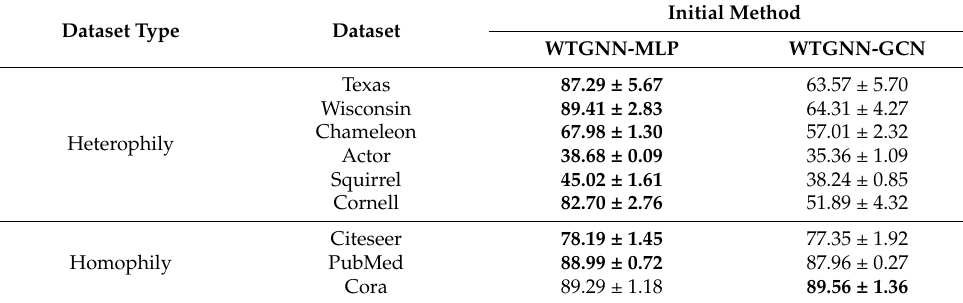
Table 7. Performance under different initial